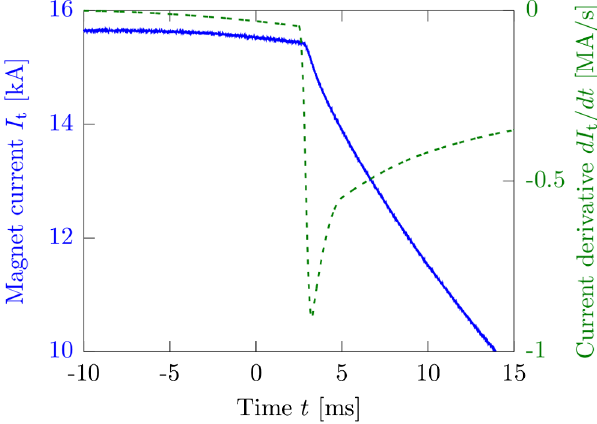
FIG. 7. Short model coil, magnet current, and its estimated derivative as a function of time after a quench starts.